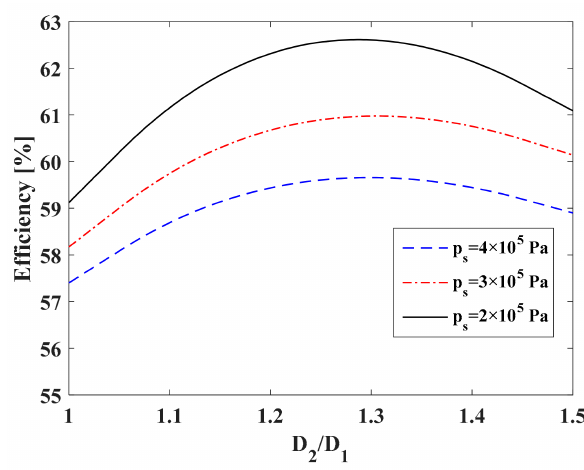
Figure 16. Relationship between energy efficiency and diameter ratio.